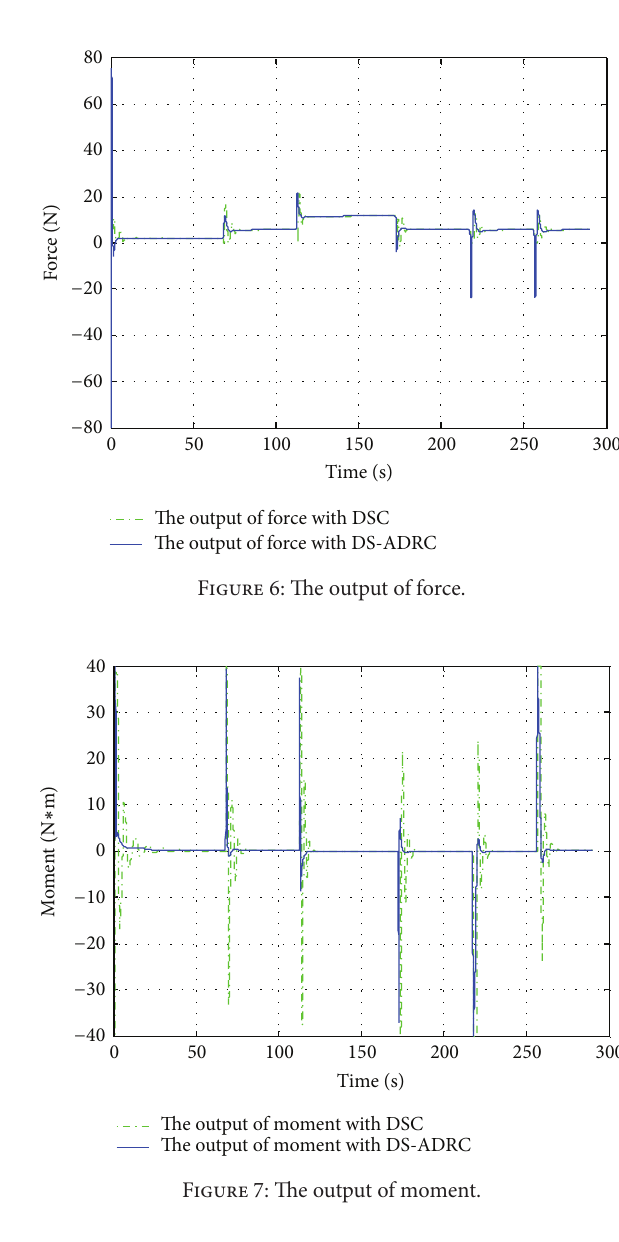
Figure 5: The cross-track error.